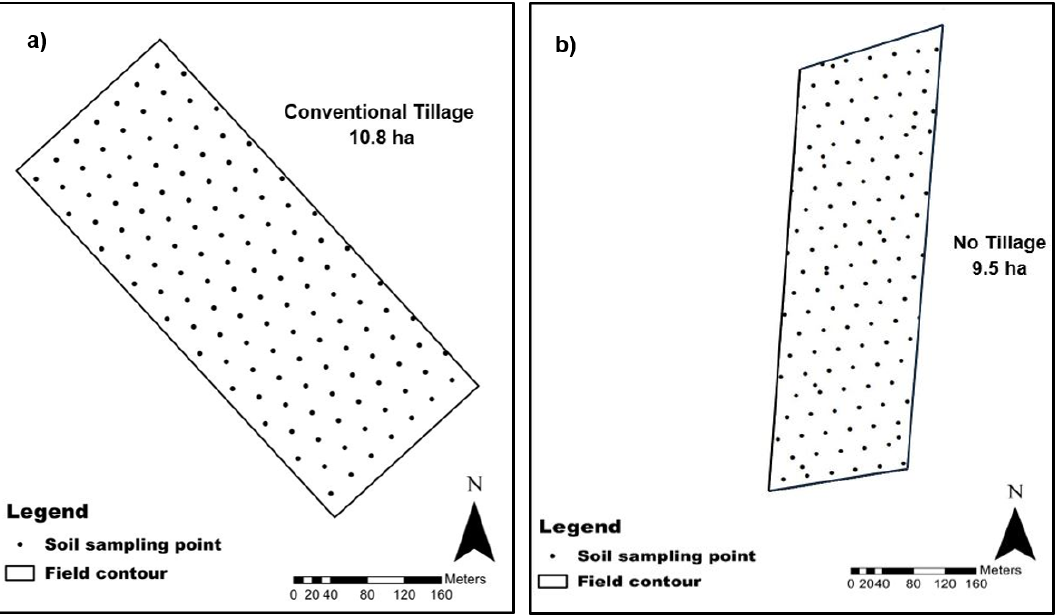
Figure 1. Location and sampling strategies of ( a ) the conventional tillage and ( b ) no-tillage fields. Soil samples were air-dried, ground and sieved through a 2 mm sieve for soil cha- racterization. Soil pH H2O (1:1 water) was measured according to Hendershot et al. [42]. The soils were extracted using Mehlich-3 solution at a 1:10 soil: solution ratio [43], and the concentrations (mg kg − 1 ) of available phosphorus (P M3 ), iron (Fe M3 ), calcium (Ca M3 ) and